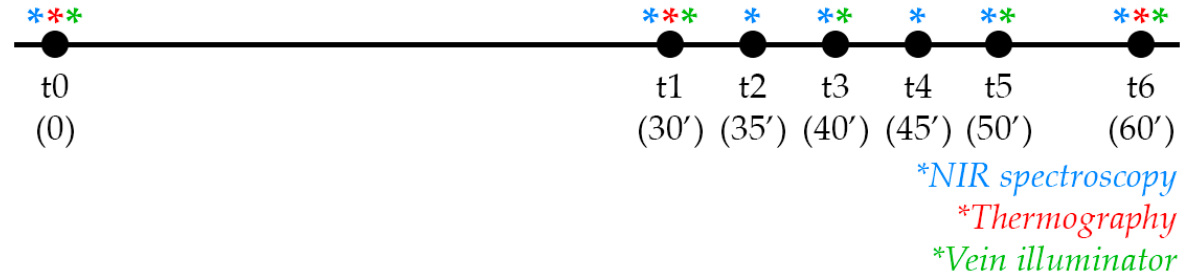
Figure 2. Timeline of the study. Different colors representing different devices used at certain